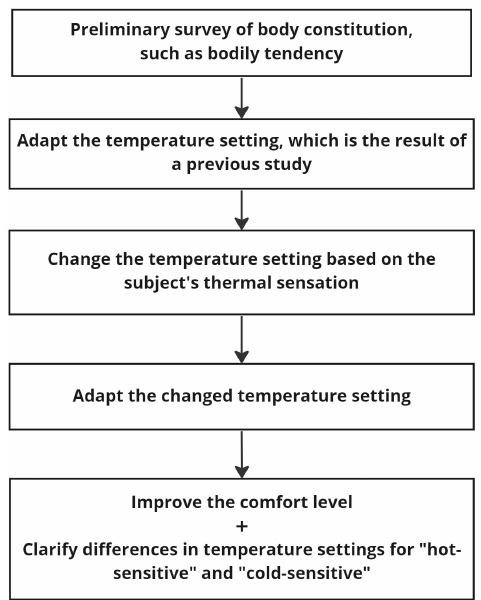
Figure 3. Flowchart of verification experiment.